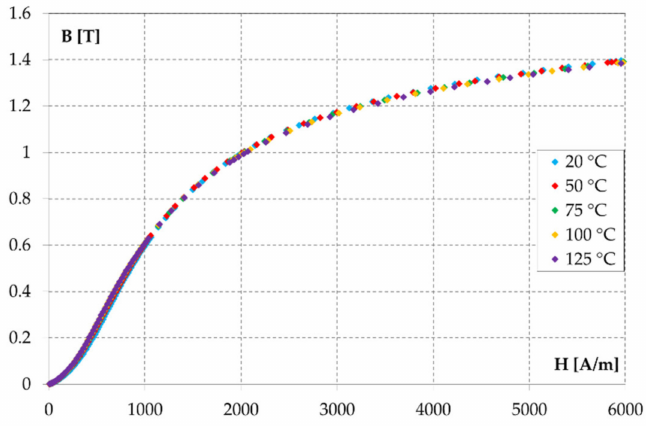
Figure 8. BH curves at different temperatures of SMC sample E 0.2-700.